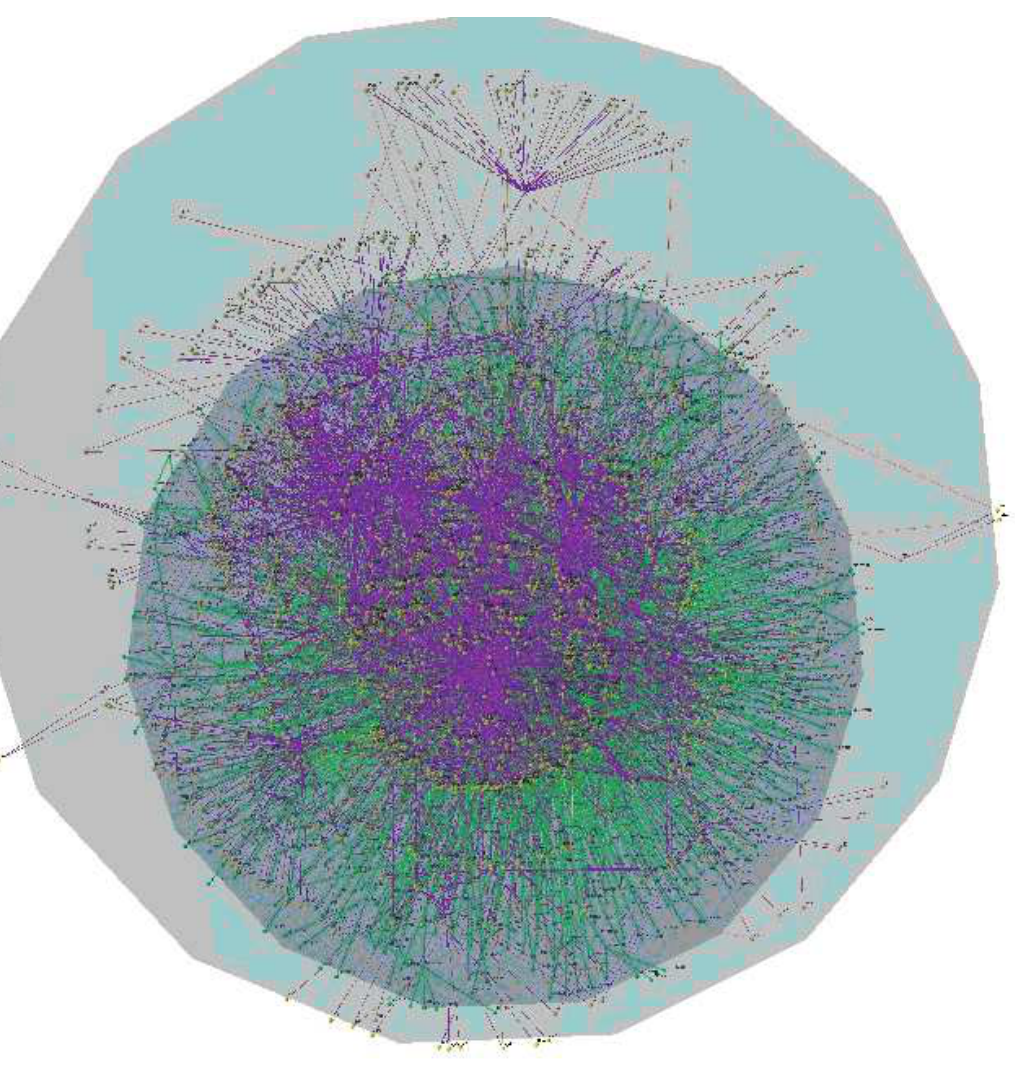
Figure 4: Visualisation of the two overlapping networks representing a gene regulatory network and and a corresponding part of a protein interaction network. The gene regulatory network is in blue, whereas the protein interaction network is in green. The proteins co-shared by both networks are in